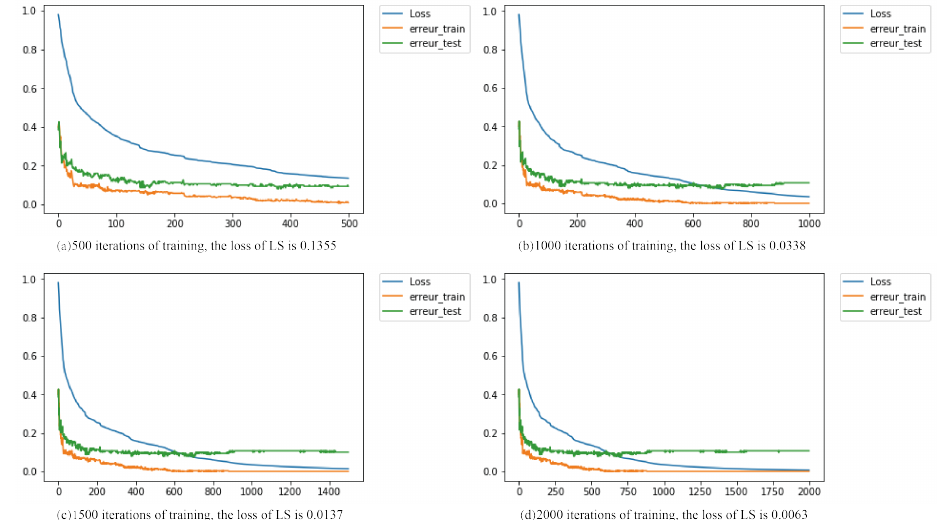
Figure 3. Training results of 500, 1000, 1500, and 2000 iterations, respectively, on a synthetic data set of 500 points.